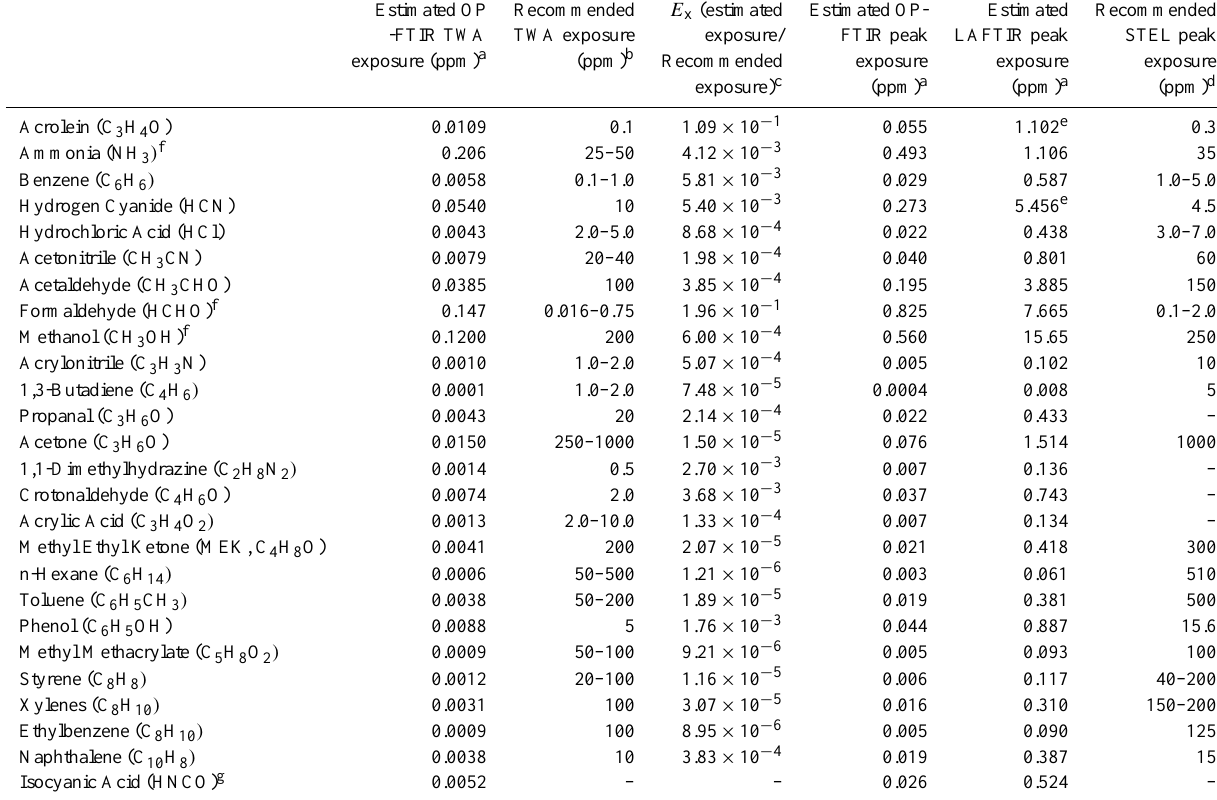
Table 4. Estimated OP-FTIR TWA burn-averaged and peak concentrations, LAFTIR peak concentrations, and recommended TWA and peak